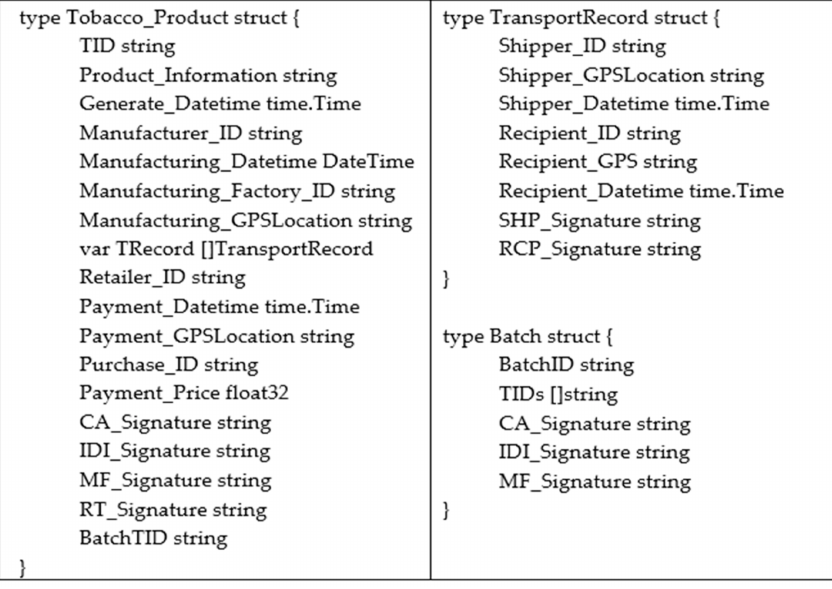
Figure 5. The chaincode structure of the tobacco